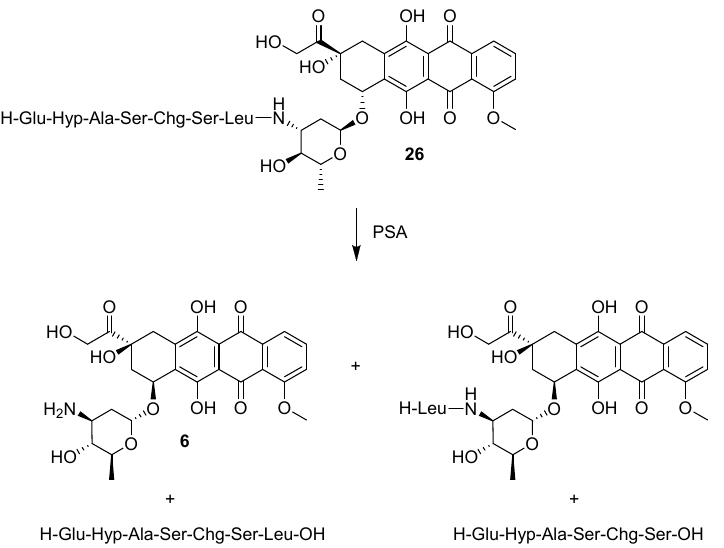
Scheme 14. Doxorubicin prodrug ( 26 ) cleaved by PSA